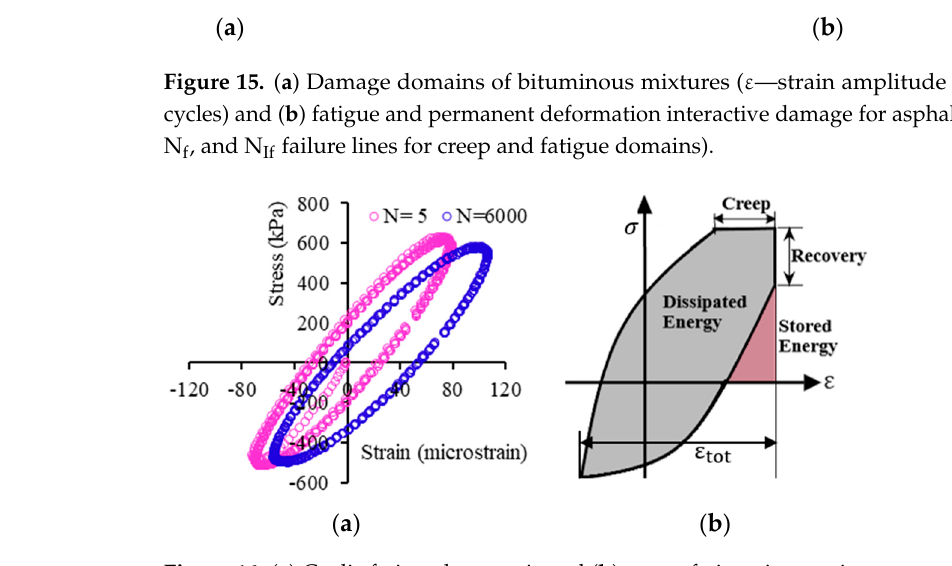
Figure 16. ( a ) Cyclic fatigue hysteresis and ( b ) creep–fatigue interaction stress–strain loop.